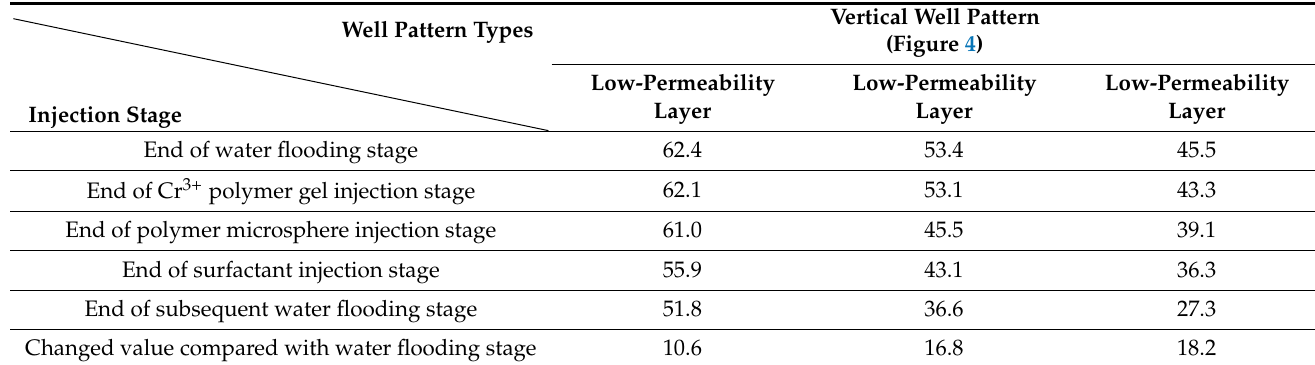
Figure 16. Remaining oil distribution of each layer after subsequent water flooding stage of Figure 4: ( a ) low-permeability layer, ( b ) medium-permeability layer, ( c ) high-permeability layer. Table 9. The remaining oil saturation (%) results of Figure 4 .